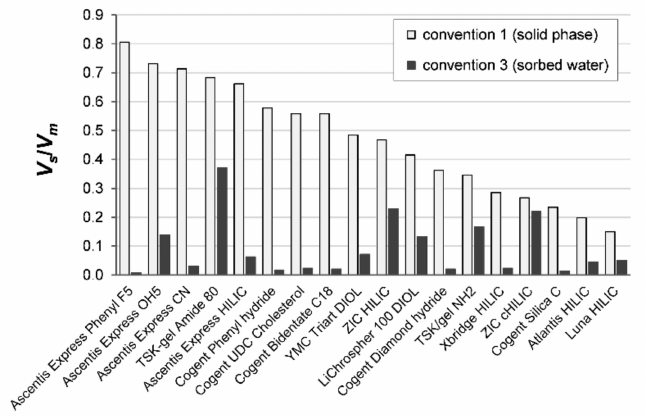
Figure 5. The volume ratios of the stationary ( V s ) and mobile ( V m ) phases according to convention 1 (stationary phase = solid phase)—blank blocks—and convention 3 (stationary phase = sorbed water diffuse layer)—black blocks—for 18 polar